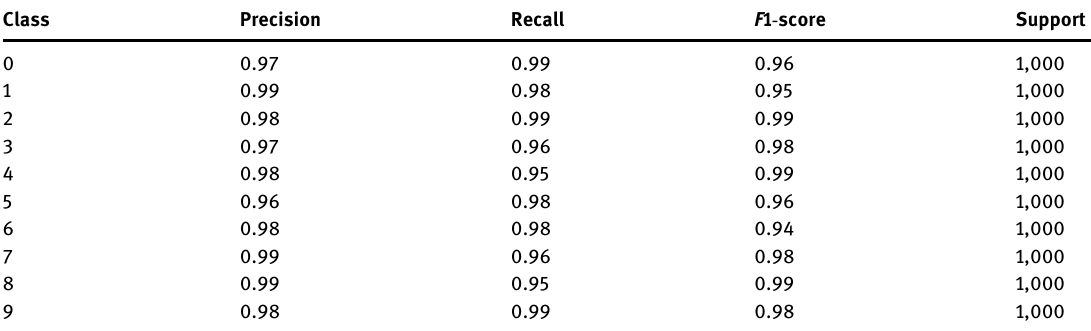
Table 8: Classi fi cation for each one class